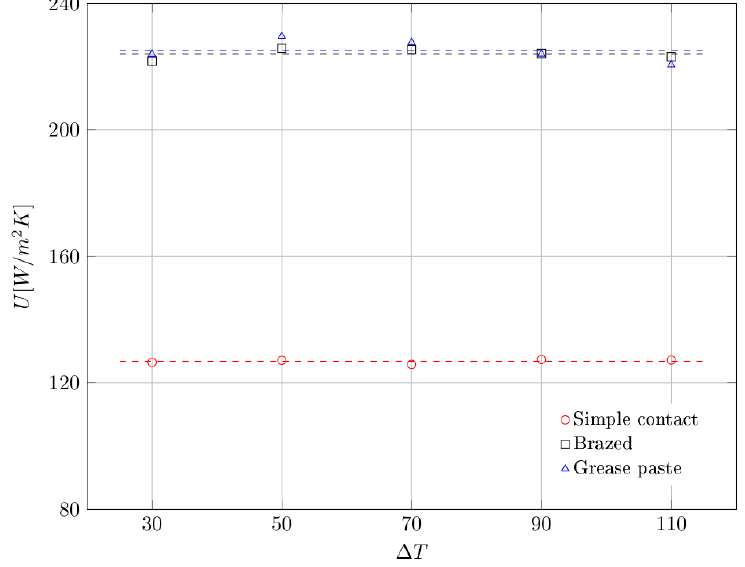
Figure 9. Global heat transfer coefficient as a function of differential temperature, for each type of contact. Dashed lines represent the average values. Table 3. Experimental values of global heat transfer coefficient as a function of differential temperature.